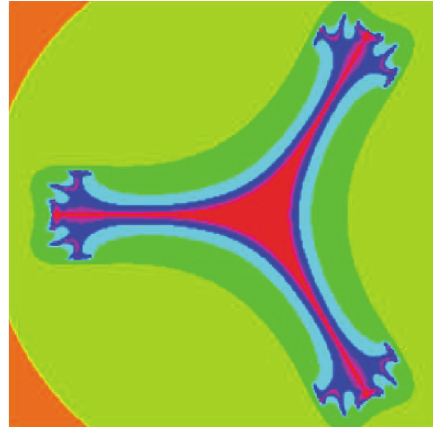
Figure 7: Relative superior multicorn for 𝑠 = 1.0 and 𝑠 󸀠 = 1.0 .